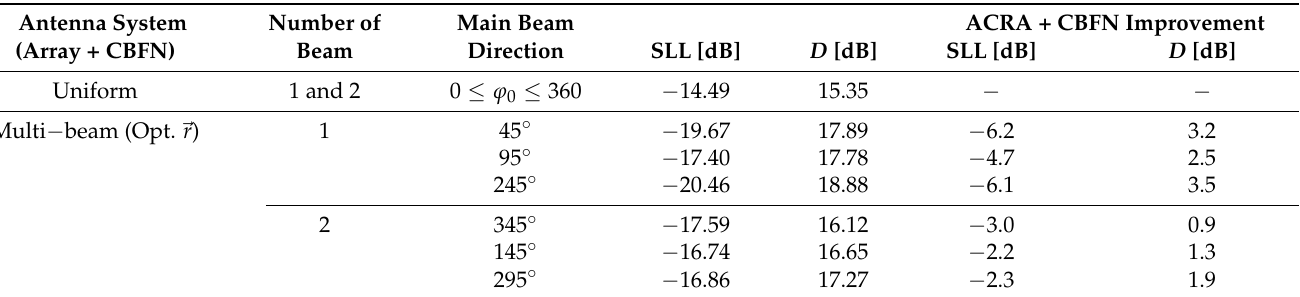
Table 1. Results of the conducted experiments and mean values of the non-uniformity improvement on the proposed antenna system in terms of sidelobe level (SLL) and D